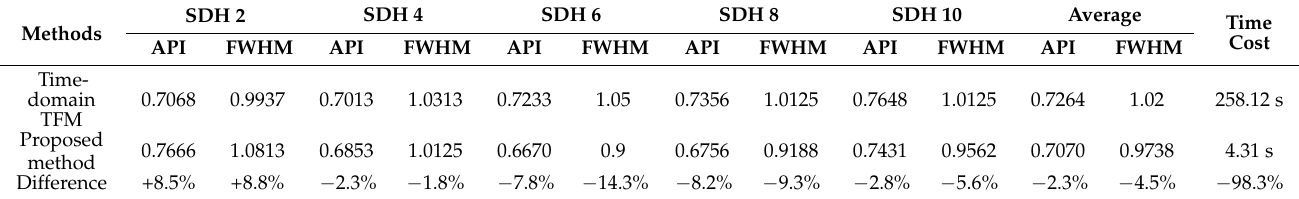
Table 2. Representative APIs and time costs with different imaging methods in simulation.